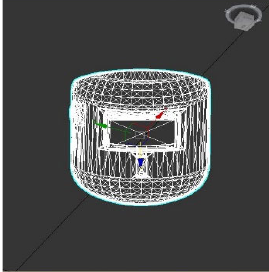
Fig. 3. Optimizing and editing the mesh of CAD model in 3ds Max.